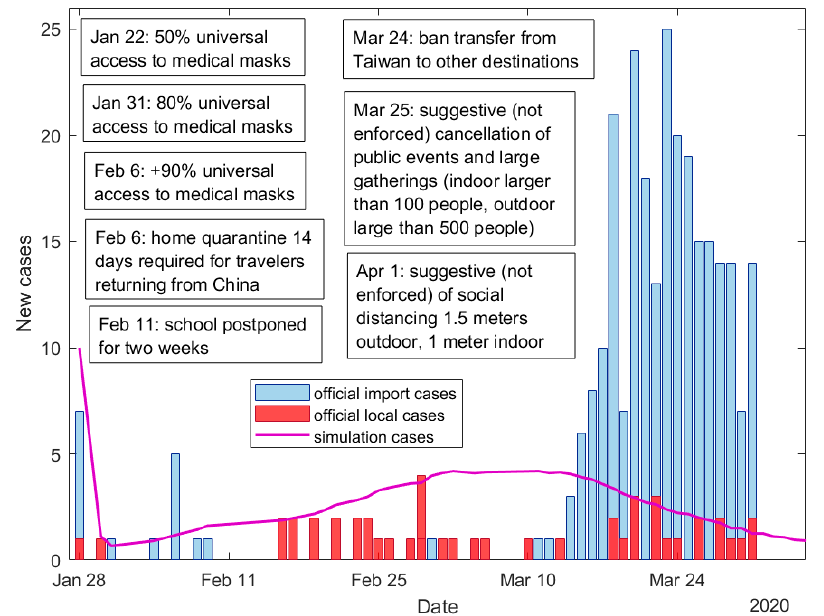
Figure 6. Comparison of official data in Taiwan during January–March 2020 with simulated results and implemented interventions in Taiwan during this period [13]. R 0 = 2.5, R a = 1.875, 4 days of mean delay, 40% transmission before symptoms, initial number of symptomatic and asymptomatic cases is the same and equal to 5, 80% of people wear masks and the mask hinders spreading and protects from getting infected with mask efficiency 𝑒 (cid:3040) = 50%, 60% of contacts are traced.